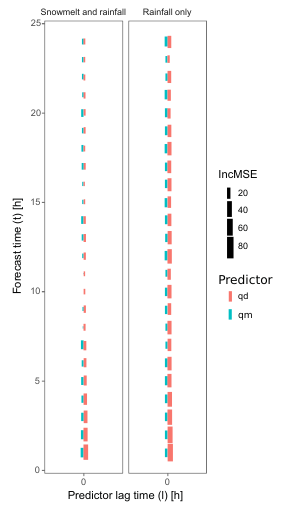
Figure 8. Importance of the forecasted meteorological predictors used in the Random Forests models (Equations (1) and (2)) for snowmelt and rainfall ( left panel) and rainfall only ( right panel) model variants. The vertical axis presents different forecast time t ∈ (cid:104) 1;24 (cid:105) h; the horizontal axis presents the predictor lag time l ∈ (cid:104)− 24; t (cid:105) h. The area of the rectangles is proportional to increase of the mean squared error (IncMSE) of Random Forests model after perturbing a predictor in reference to an original predictor, i.e., the higher the increase of the mean squared error, the higher the predictor importance for a model. Red rectangles present rainfall predictors ( r l ) and the blue rectangles present the snowmelt predictors ( s l ).